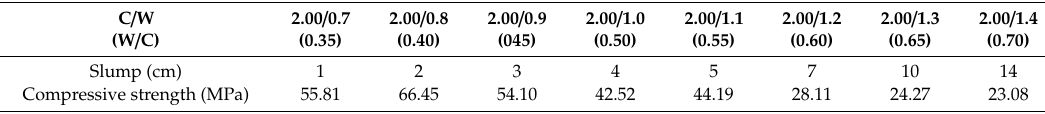
Table 9. Compressive strength and slump with various amount of water at the 28-day age.